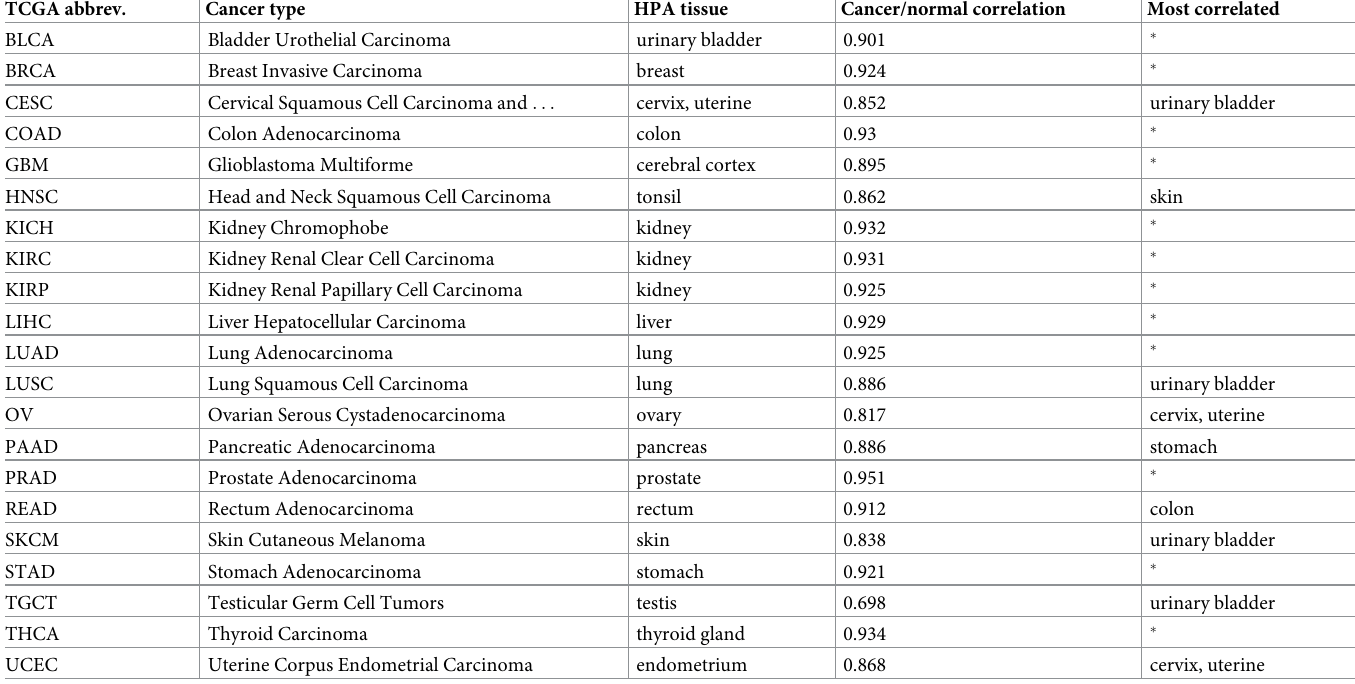
Table 1. The 21 analyzed TCGA cancer types and corresponding HPA normal tissues. The ‘Cancer/normal correlation’ column contains the Spearman rank correlation between the mean gene expression values in the TCGA cancer samples (i.e., the c i , j statistics) and the mean expression values in the associated HPA normal tissue (i.e., the n i . j statistics). The ‘Most correlated’ column lists the HPA normal tissue whose mean expression had the highest rank correlation with cancer mean expression. A value of ‘ � ’ indicates that the associated normal tissue had the largest correlation. TCGA